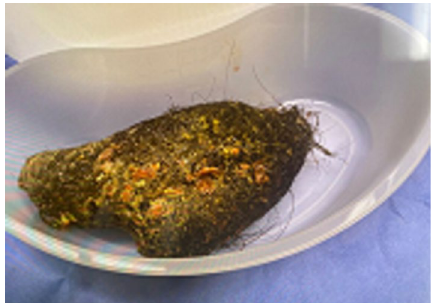
Fig. 1 A photograph of the 13.0 × 6.5 cm × 5.0 cm gastric trichobezoar extracted after an exploratory laparotomy and anterior gastrotomy. Hair extracted from the patient’s weave and fragments of food are